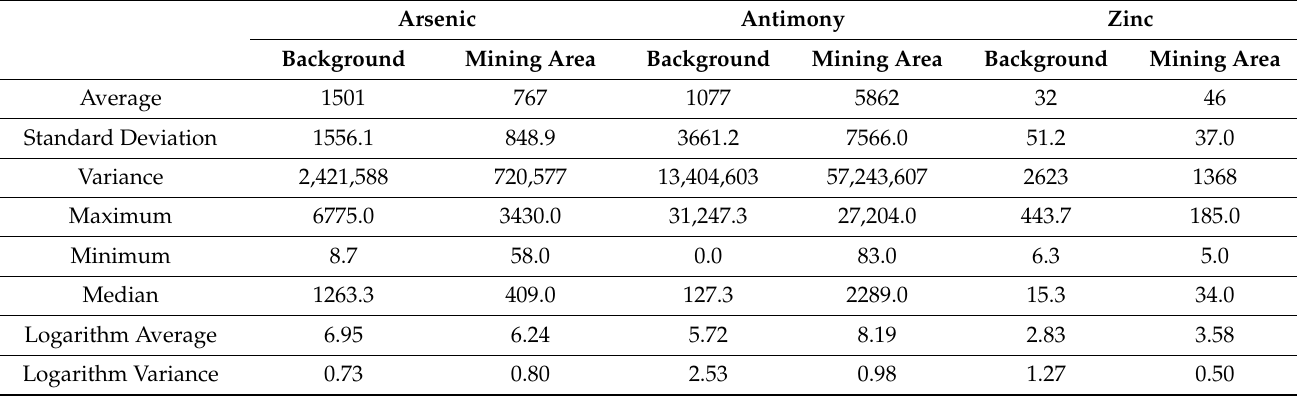
Table 1. Comparison of elements of concern in two different areas (concentrations in